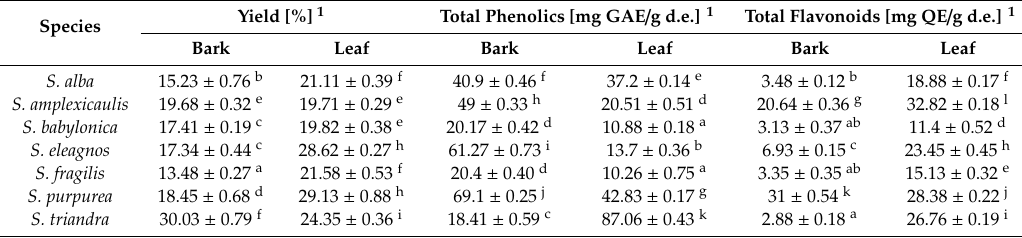
Table 1. Yield of dried extract, total phenolics and total flavonoid content in bark and leaves extracts of the investigated Salix species. 1 Total Phenolics [mg GAE / g d.e.] Species Yield [%]